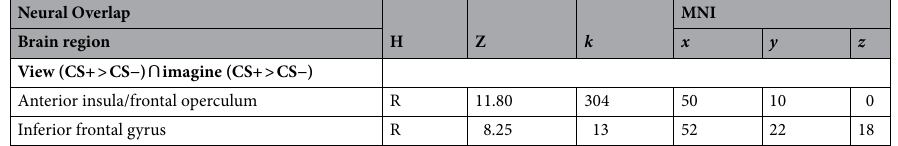
Table 2. Day 1, conditioning phase: neural overlap. The results in this table are derived from taking the product of two independent whole-brain maps each of which was thresholded and cluster-corrected independently for multiple comparisons (see “Methods” for further details). H = principal hemisphere of the cluster, right (R) or left (L); Z = maximum z-value of cluster; k = number of contiguous voxels in the cluster; MNI(X,Y,Z) = coordinates of the center of gravity in the standardized space of the Montreal Neurological Institute (MNI), represented in units of millimeters (mm). All whole-brain unthresholded group-level maps can be viewed at neurovault.org (see “Methods”).